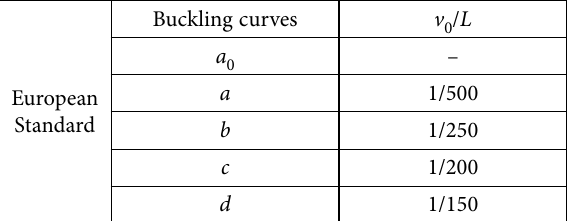
Table 4. Values of member initial bow